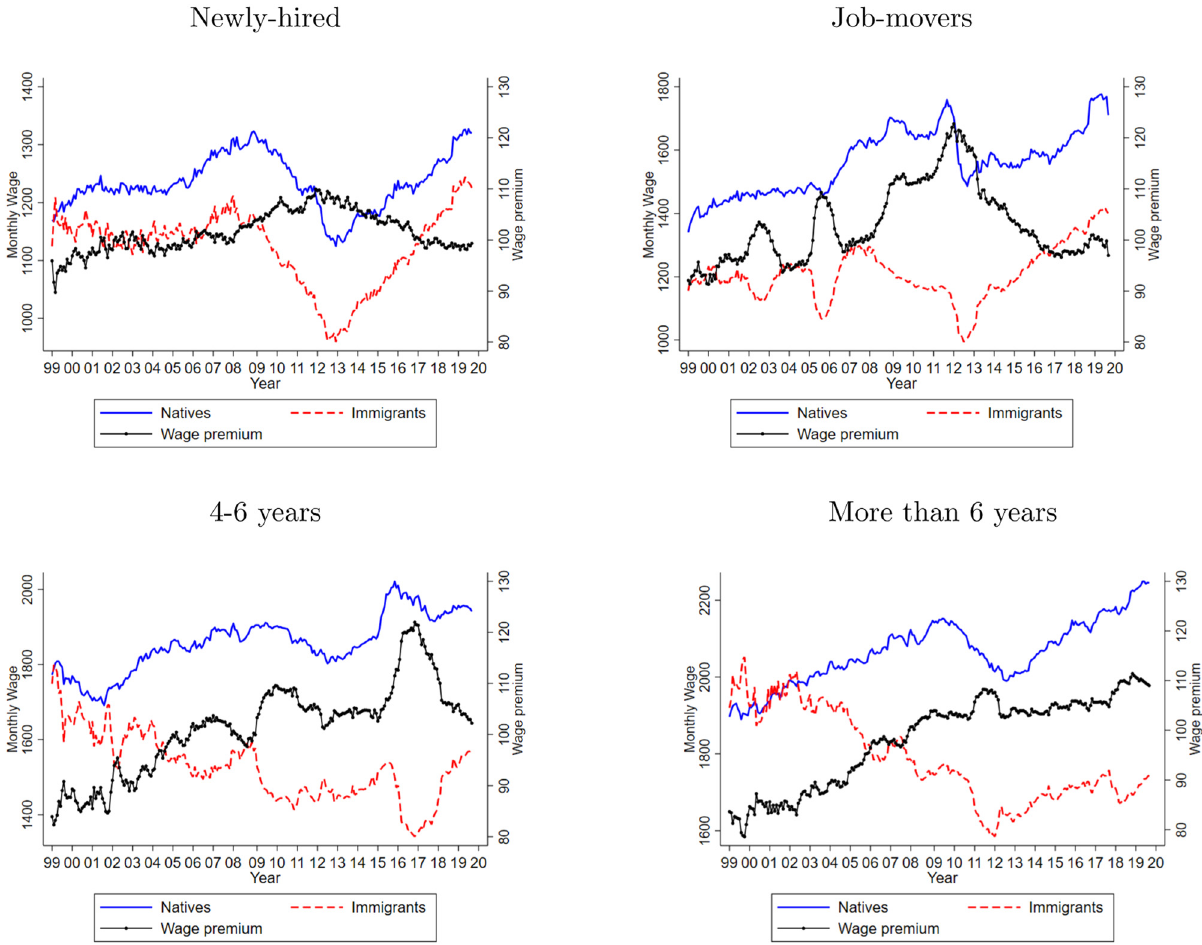
Figure 8: Monthly average wage by nationality and tenure. Note: The wage premium is computed as ( ) / w w ¯ ¯ − 1 N t M t , , , where w ¯ j t , is the monthly average wage for natives = j N and immigrants = j M at month t . Wage premium is normalised to 100 at Q 2008 1 . Wages are